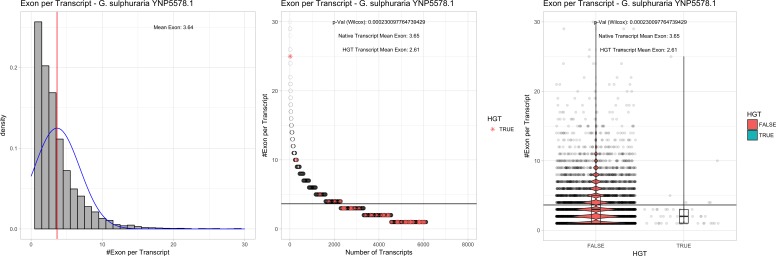
Exon/Intron – Galdieria sulphuraria YNP5578.1: (Left) Mid) Cumulative %GC distribution of transcripts.Red line shows the average, blue line a normal distribution based on the average value. The data is categorical (genes have either one, two, three etc. exons) and does not follow a normal distribution. (Mid) Ranking all transcripts based upon their number of exons. Red ‘*' demarks HGT candidates. As the number of exons was not normally distributed, transcripts were ranked by number of exons. In order to resolve the high number of tied ranks (e.g. many transcripts have two exons) a bootstrap was implied by which the rank of transcripts sharing the same number of exons was randomly assigned 1000 times. Wilcoxon-Mann-Whitney-Test applied for the determination of significant rank differences between the native gene and the HGT candidate subset. (Right) Violin plot showing the number of exons per transcript distribution across native transcripts and HGT candidates.